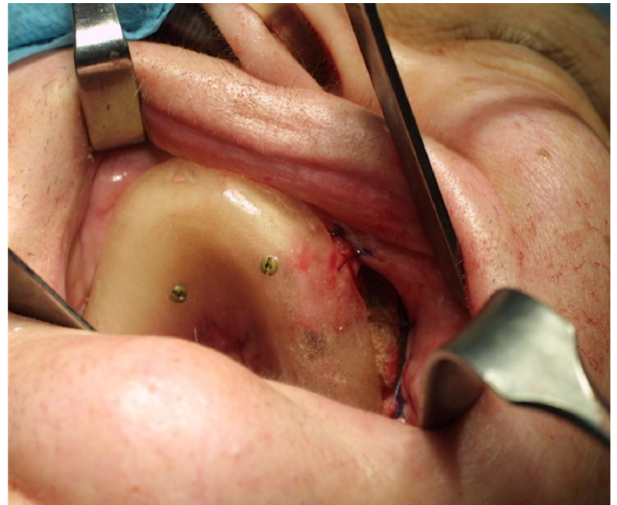
Figure 3. Full-thickness skin graft stabilized with a gauze dressing and a previously made palatal plate attached with a bicortical titanium screws.